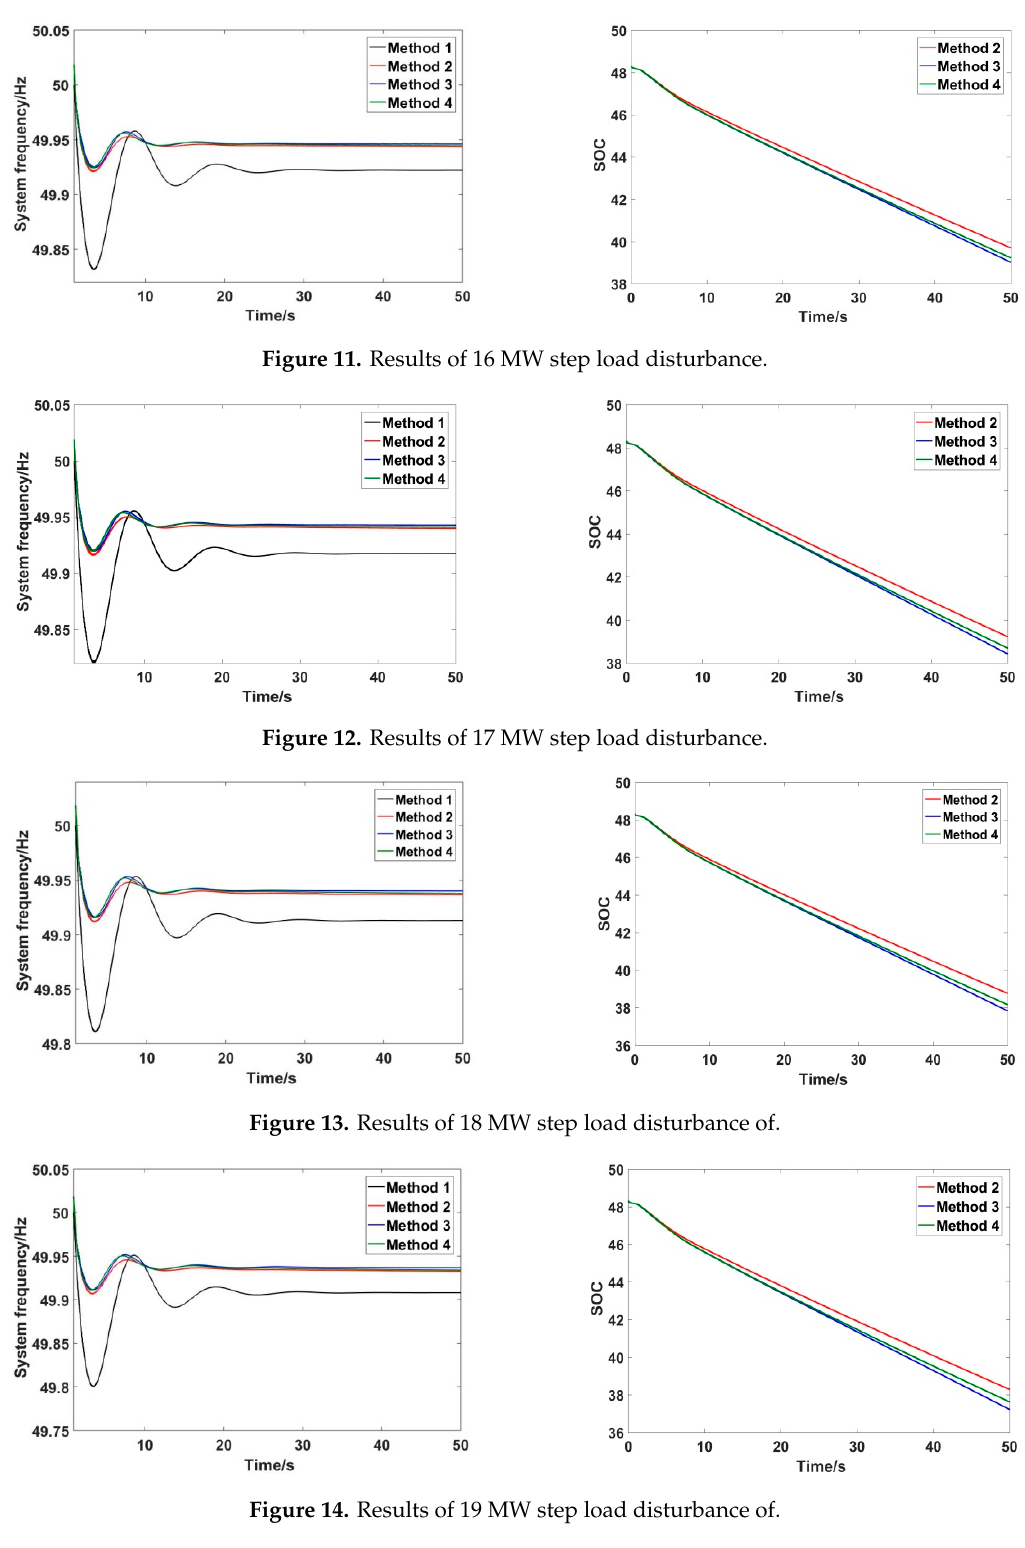
Figure 14. Results of 19 MW step load disturbance of.